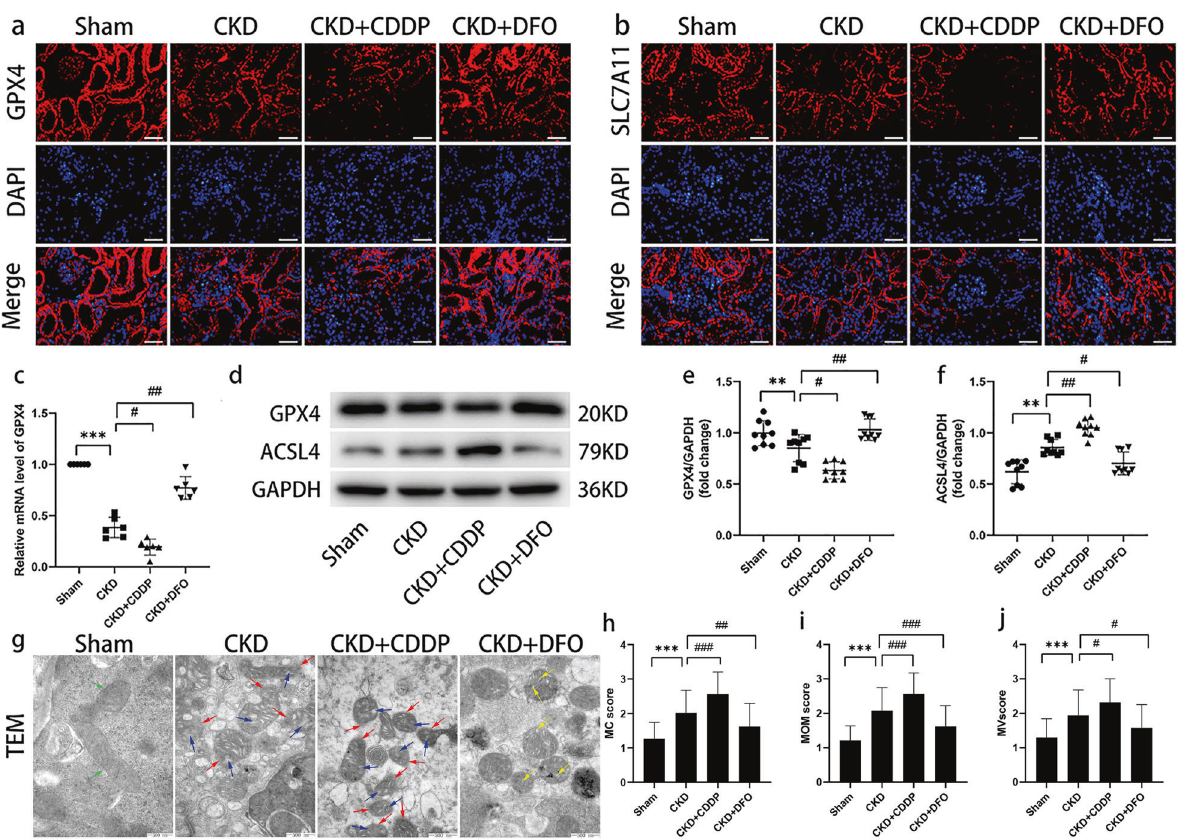
Fig. 2 Typical features of ferroptosis present in CKD rats. Biochemical trends ( a – f ) and pathological evidence ( g – j ) of ferroptosis in CKD rats. Green arrow, normal mitochondria; red arrow, MOM rupture; blue arrow, reduction or loss of MC; yellow arrow, MC swelling. ** P < 0.01, *** P < 0.001 vs. Sham group; # P < 0.05, ## P < 0.01, ### P < 0.001 vs. CKD group. Scale bar in ( a ) = 50 μ m. Scale bar in ( f ) = 500 μ